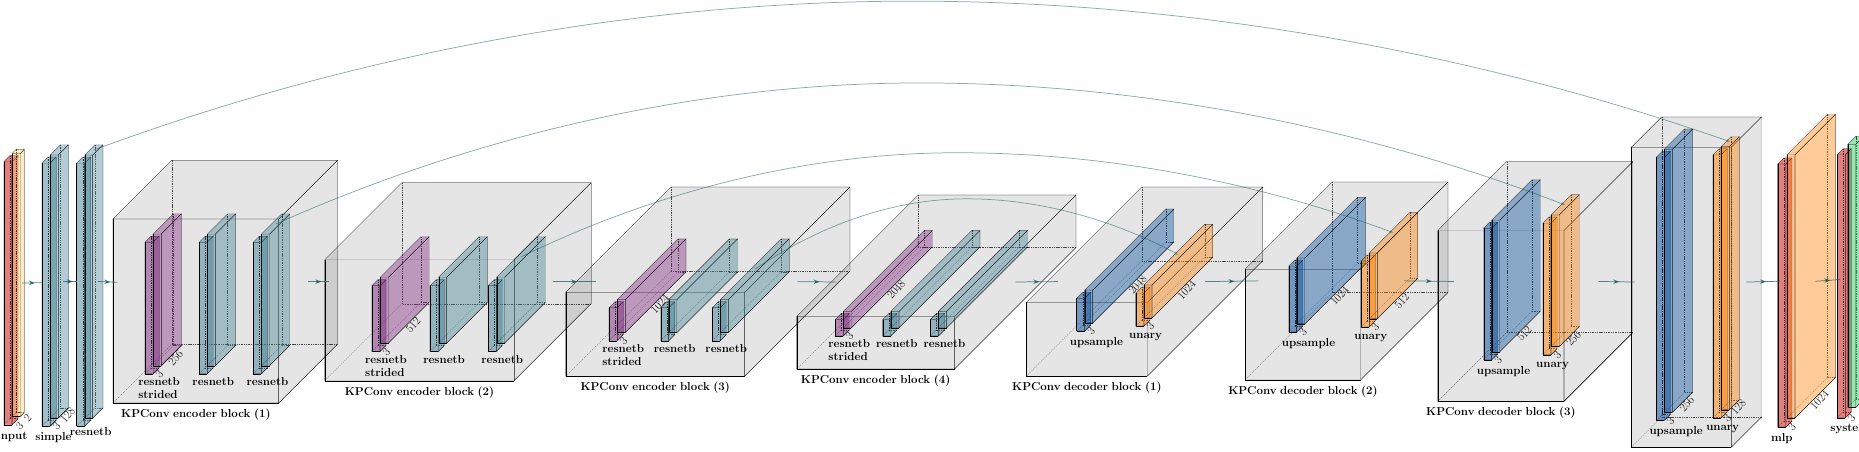
Figure A6. Network architecture used in the investigations in this paper. The base structure is similar to the original publication [29]. The input vector size equals roughly 120,000–150,000 based on the input